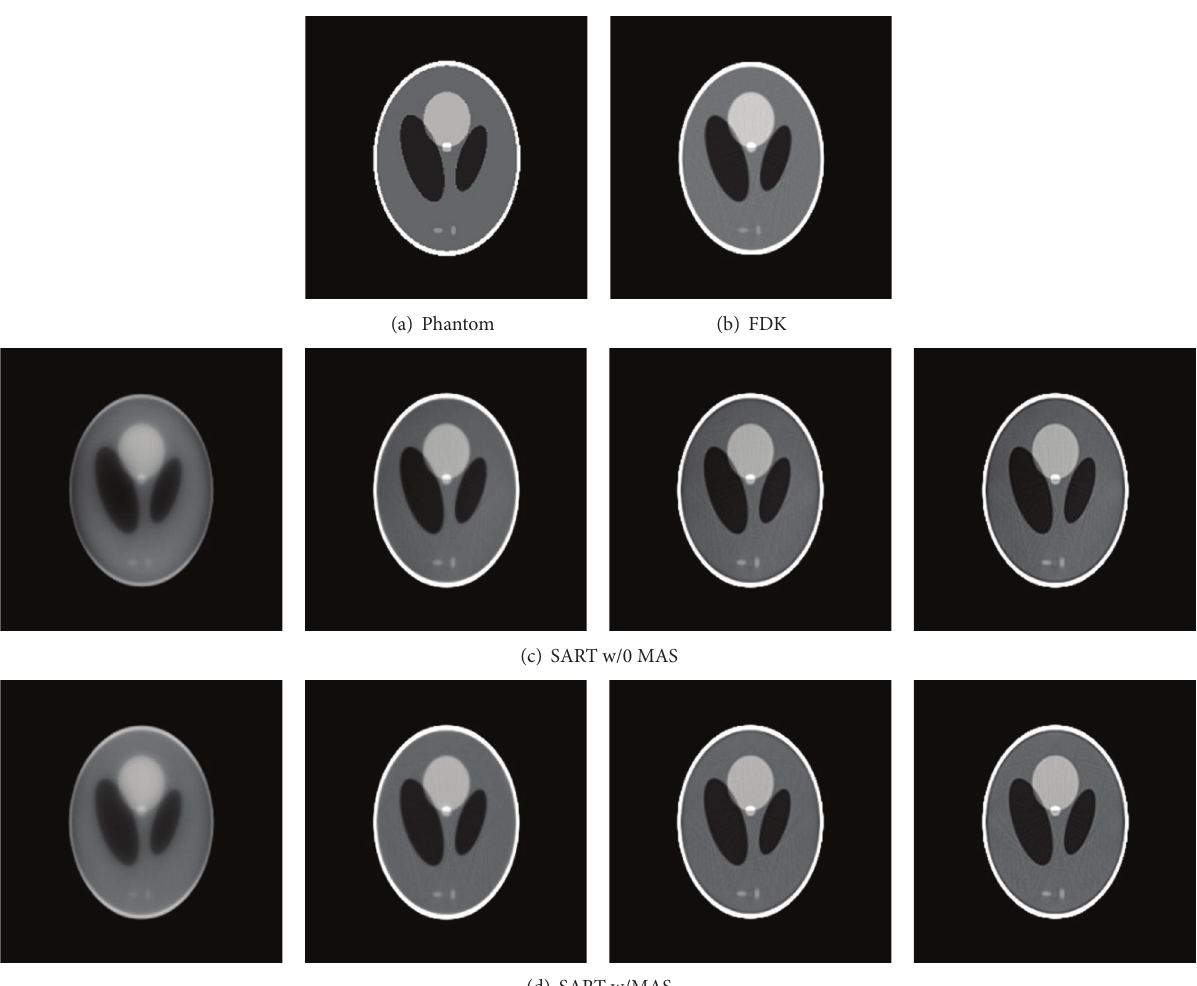
Figure 4: Reconstructions of the (a) Shepp-Logan phantom using the (b) FDK, (c) SART without the MAS ordering scheme, and (d) SART with the MAS ordering scheme. The four columns in (c) and (d) show reconstructed images after 1, 5, 10, and 15 iterations for the SART methods. The display window is set to [0.99 1.05].